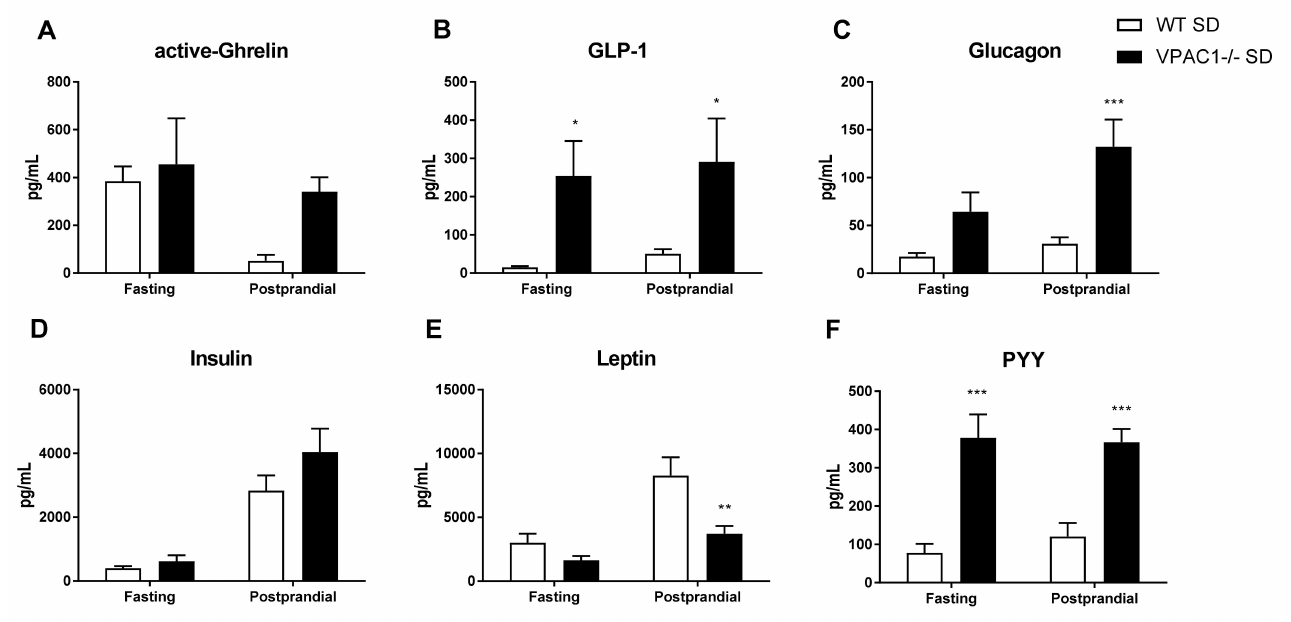
Figure 5. Plasma levels of a panel of orexigenic and anorexigenic metabolic hormones assayed in WT mice and VPAC1 − / − mice: active-Ghrelin ( A ), GLP-1 ( B ), glucagon ( C ), insulin ( D ), leptin ( E ), and PYY ( F ) were measured in either fasting or postprandial conditions. A 2-factor ANOVA analysis was used to compare averages. Values are means ± SEMs. * p < 0.05, ** p < 0.01, *** p <